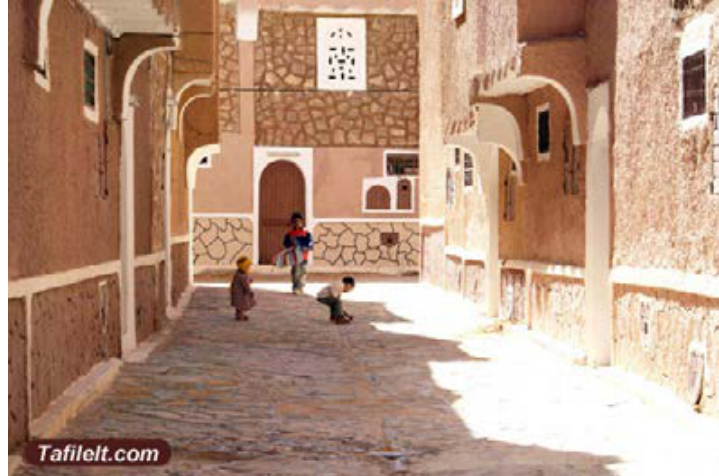
Figure 7. Courtyard as a children play area